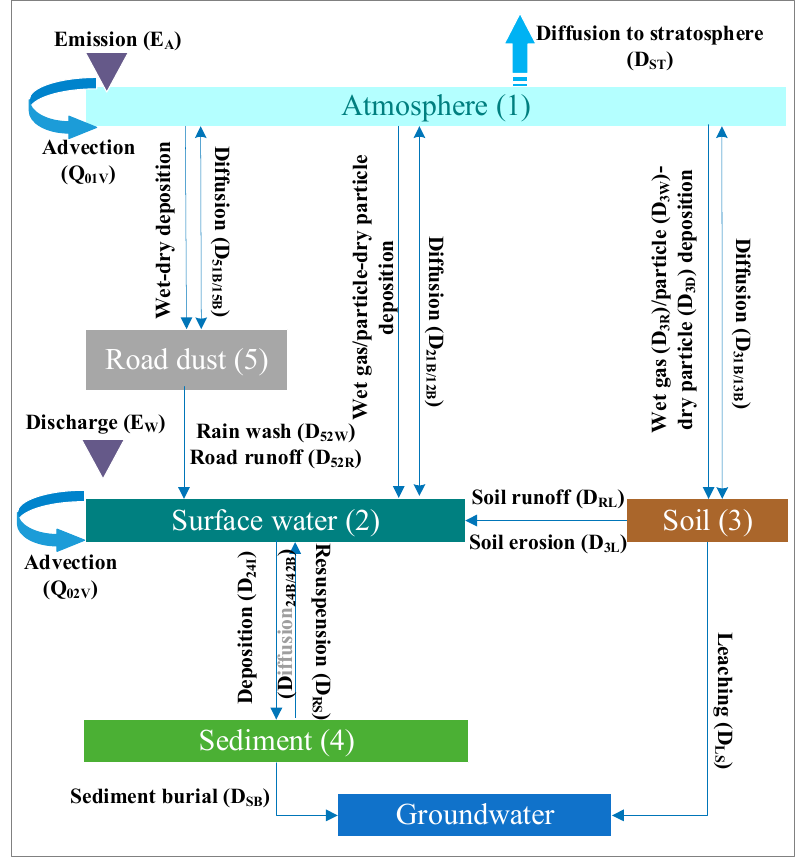
Figure 1. The conceptual fate and transport model of metals.